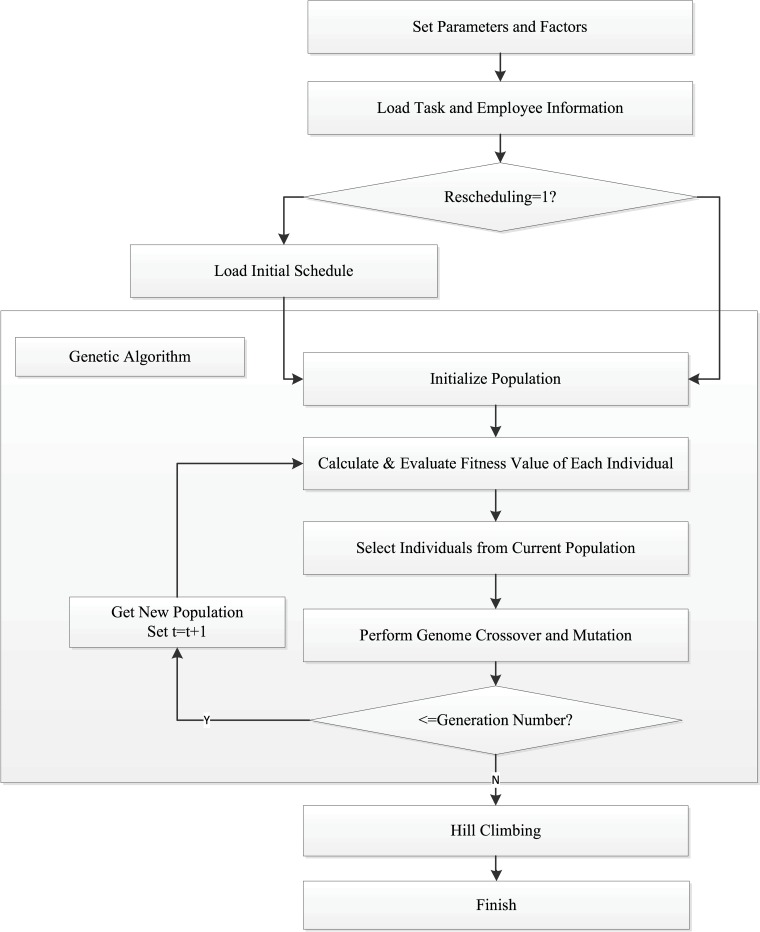
Process of Scheduler Optimizer.